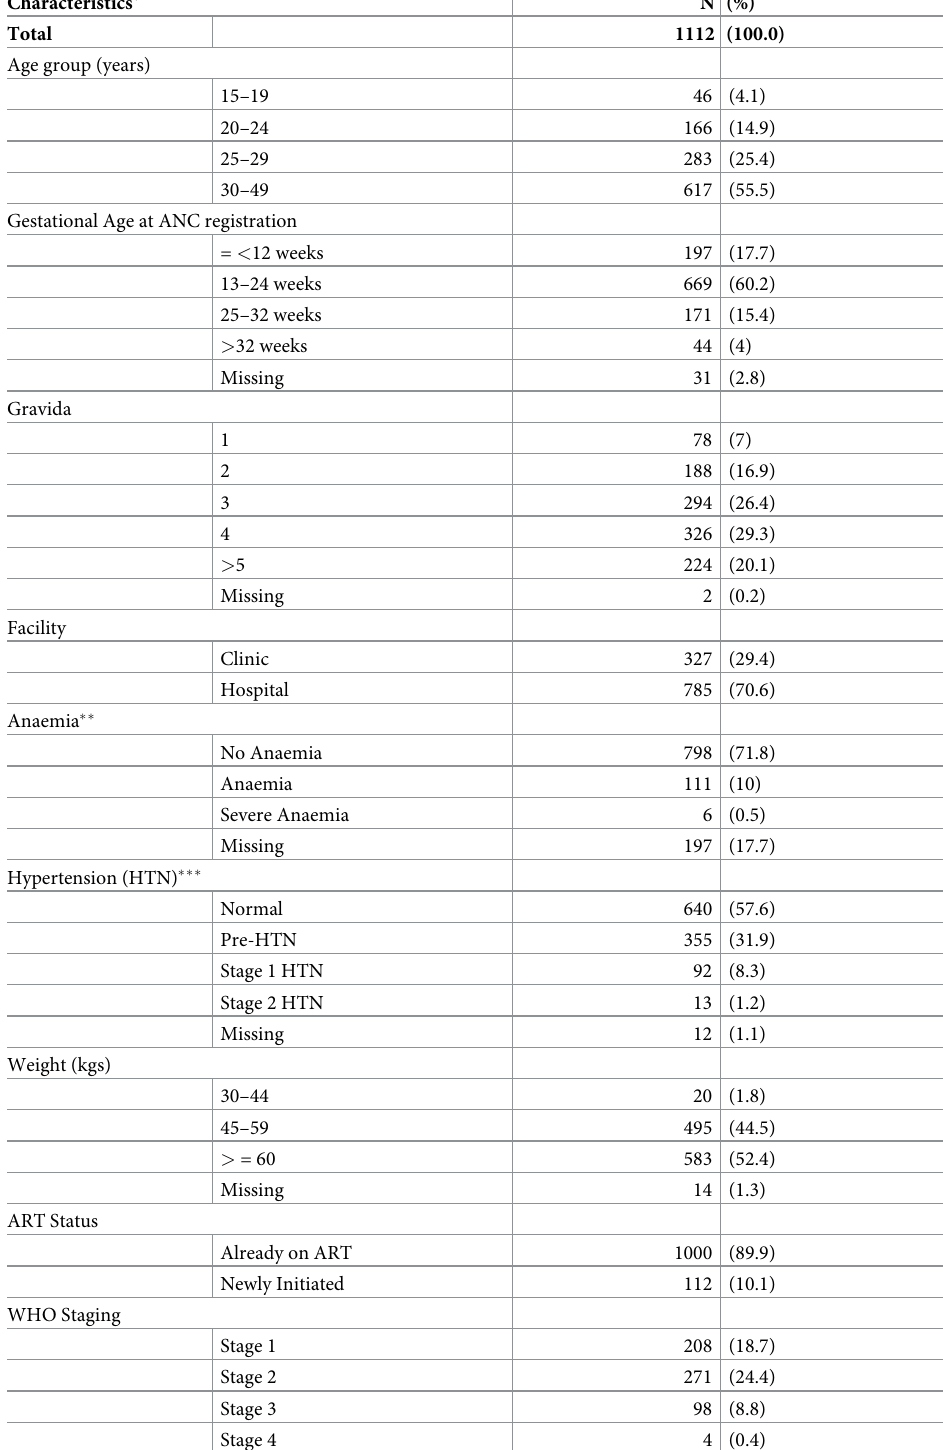
Table 1. Demographic and clinical characteristics of pregnancy cohort (living with HIV) registered for ante-natal care in Mazowe District, Zimbabwe